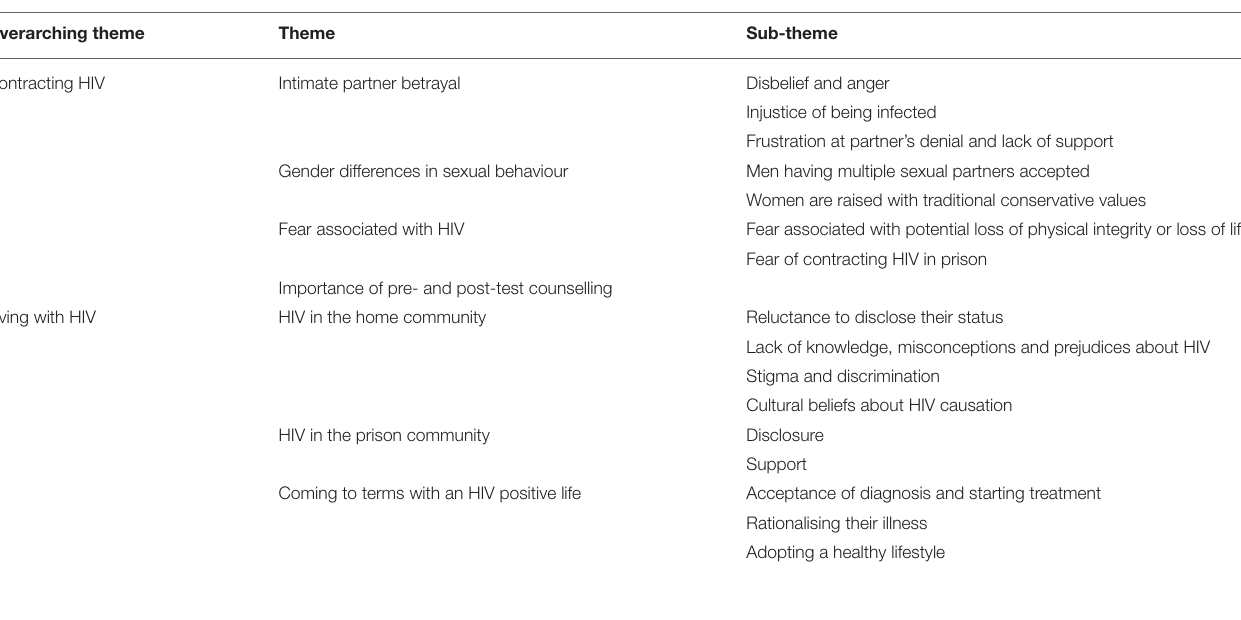
TABLE 1 | Summary of the main themes and subthemes. Overarching